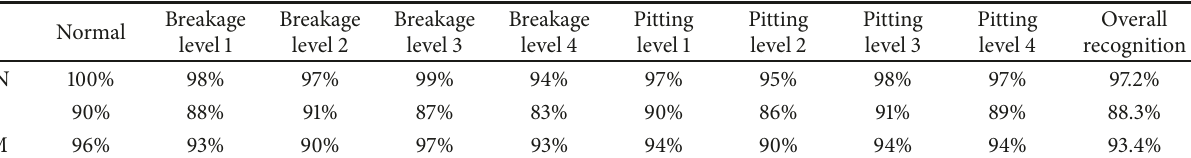
Table 3: The recognition results of CNN, BP neural network and SVM.